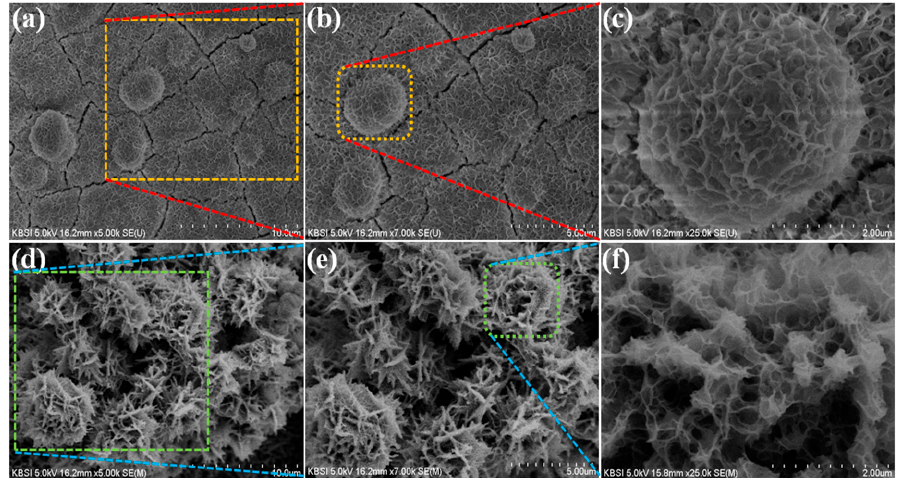
Figure 1. Morphological characterization of Nickel foam NF/NiMoO 4 and NF/NiMoO 4 /NiMoO 4 . FE-SEM images of the prepared ( a – c ) NF/NiMoO 4 and ( d – f ) of NF/NiMoO 4 /NiMoO 4 and their corresponding high magnification images.